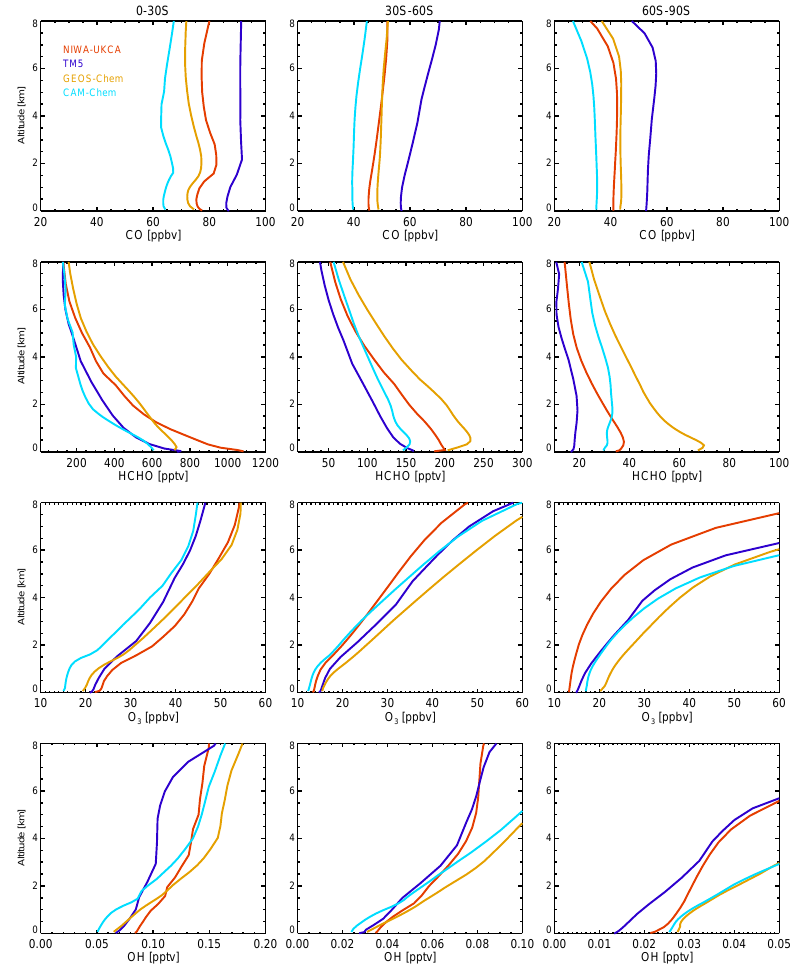
Figure 15. Monthly mean mixing ratios averaged over three SH regions (0–30, 30–60, and 60–90 ◦ S) for CO, HCHO, O 3 , and OH. Data are for January